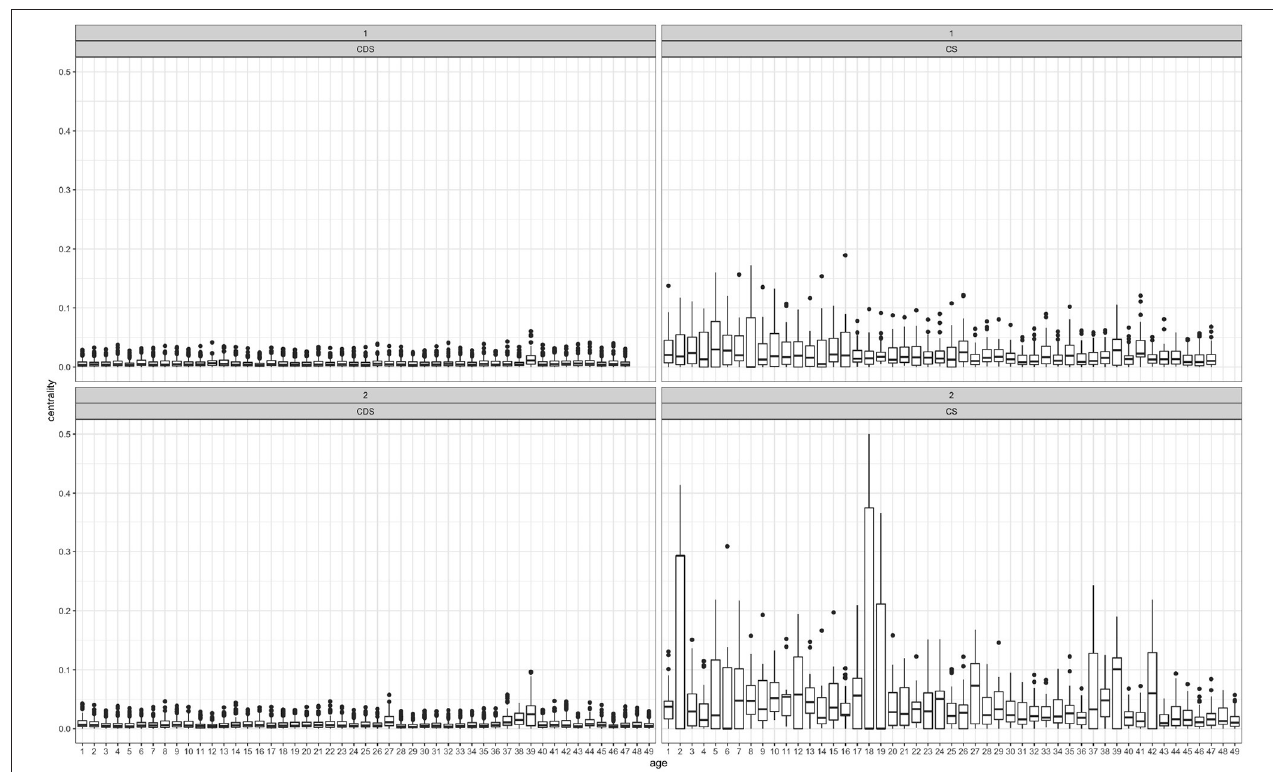
FIGURE 5 | Node centrality distribution by session: CS (right panels) and CDS (left panels), child 1 (top panels) and child 2 (bottom